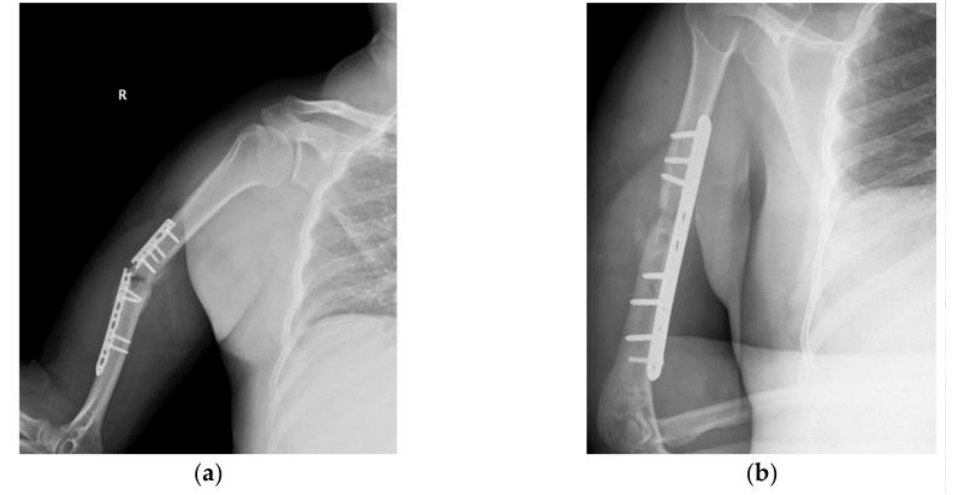
Figure 2. Clinical details: ( a ) X-ray: implant failure with subsequent plate breakage; ( b ) X-ray post-operative control after